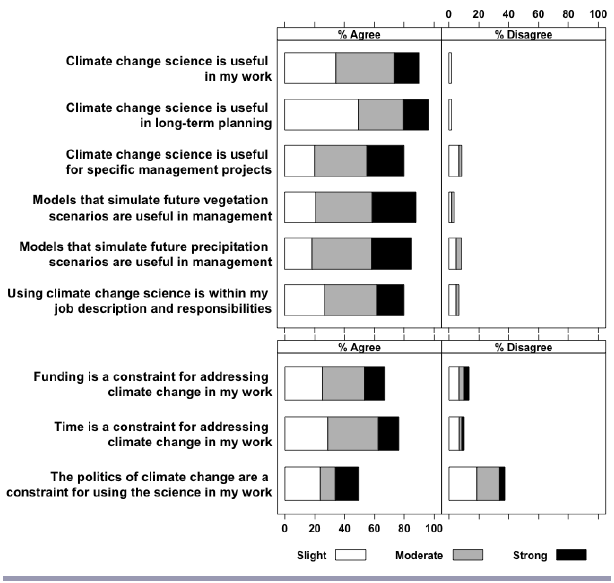
Fig. 2 . Percentage of survey participants that agreed with, felt neutral about, or disagreed with the statements in the pre- and postworkshop interviews regarding the usefulness of climate change science (top panel) and barriers to using the science to adapt or mitigate the impacts of climate change (bottom panel). The “% Agree” column displays the percentage of participants that strongly agreed (+3; black bars), agree (+2; grey bars), or slightly agreed (+1, white bars) with the listed survey statements. The same is true in the “% Disagree” column. Neutral (neither agree nor disagree) responses are not displayed; thus, bars may not sum to 100%.